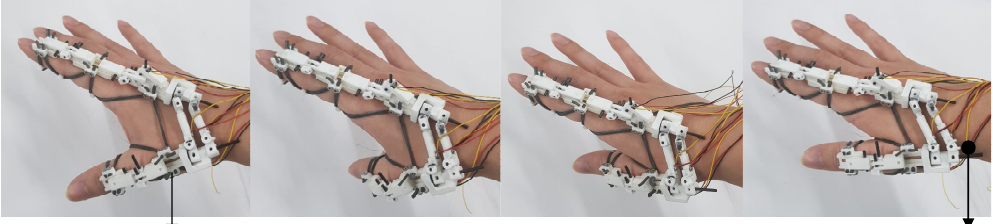
Figure 6. Proper structure alignment along various CMC joint rotations.